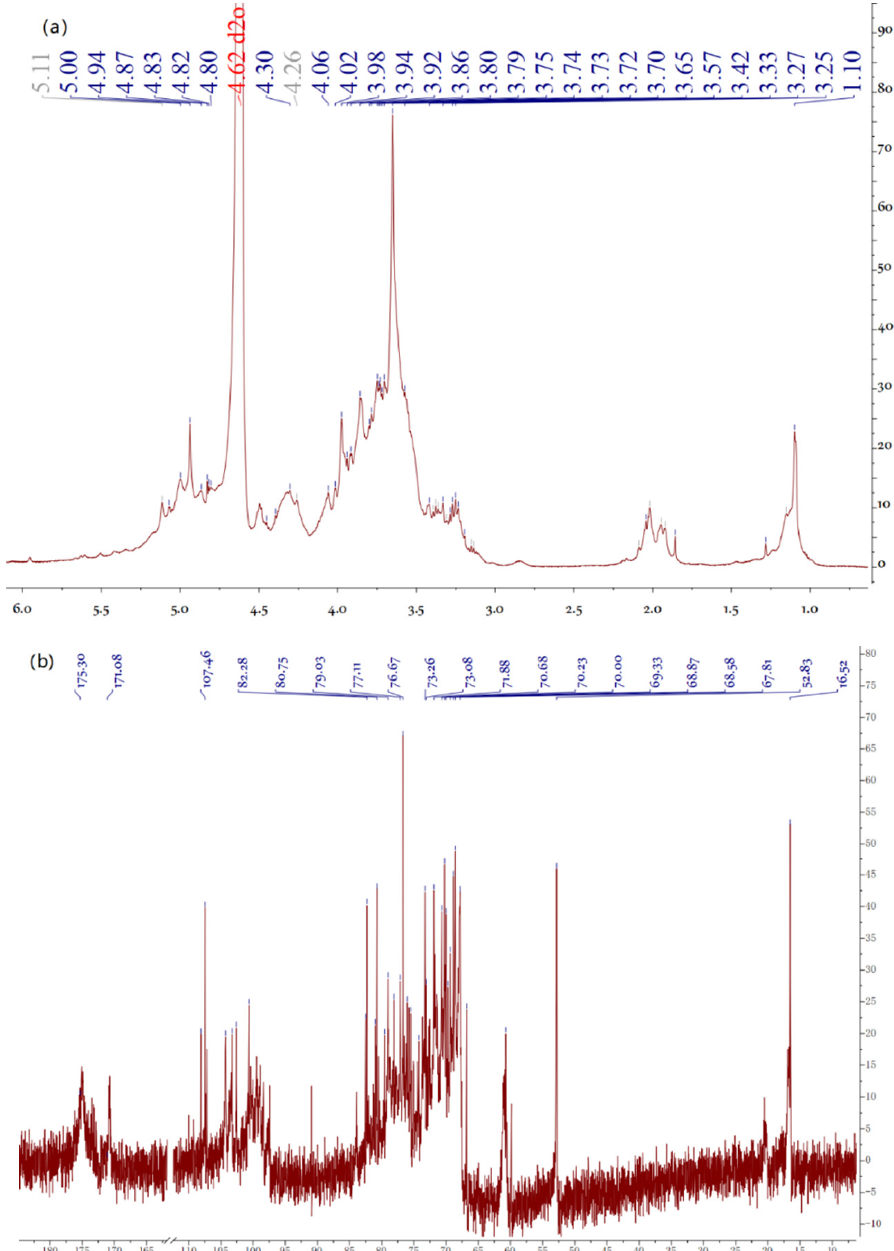
Figure 8. 1 H ( a )and 13 C ( b ) spectra of EAP-H-a2. The 13 C NMR spectrum shows characteristic signals at 174.87 ppm indicating the presence of uronic acid [24]. The presence of signals at 90–110 ppm indicates that all of the sugar residues were in the form of both α - and β -configurations. There are also six obvious chemical shifts of anomeric carbon found at 100.66, 102.58, 103.26, 104.25, 107.46, 107.19, and 108.08 ppm. There were also observed anomeric carbons with chemical shifts higher and lower than 103 ppm, indicating the existence of α and β configurations of EAP-H-a2; this was in accordance with the results of 1 H